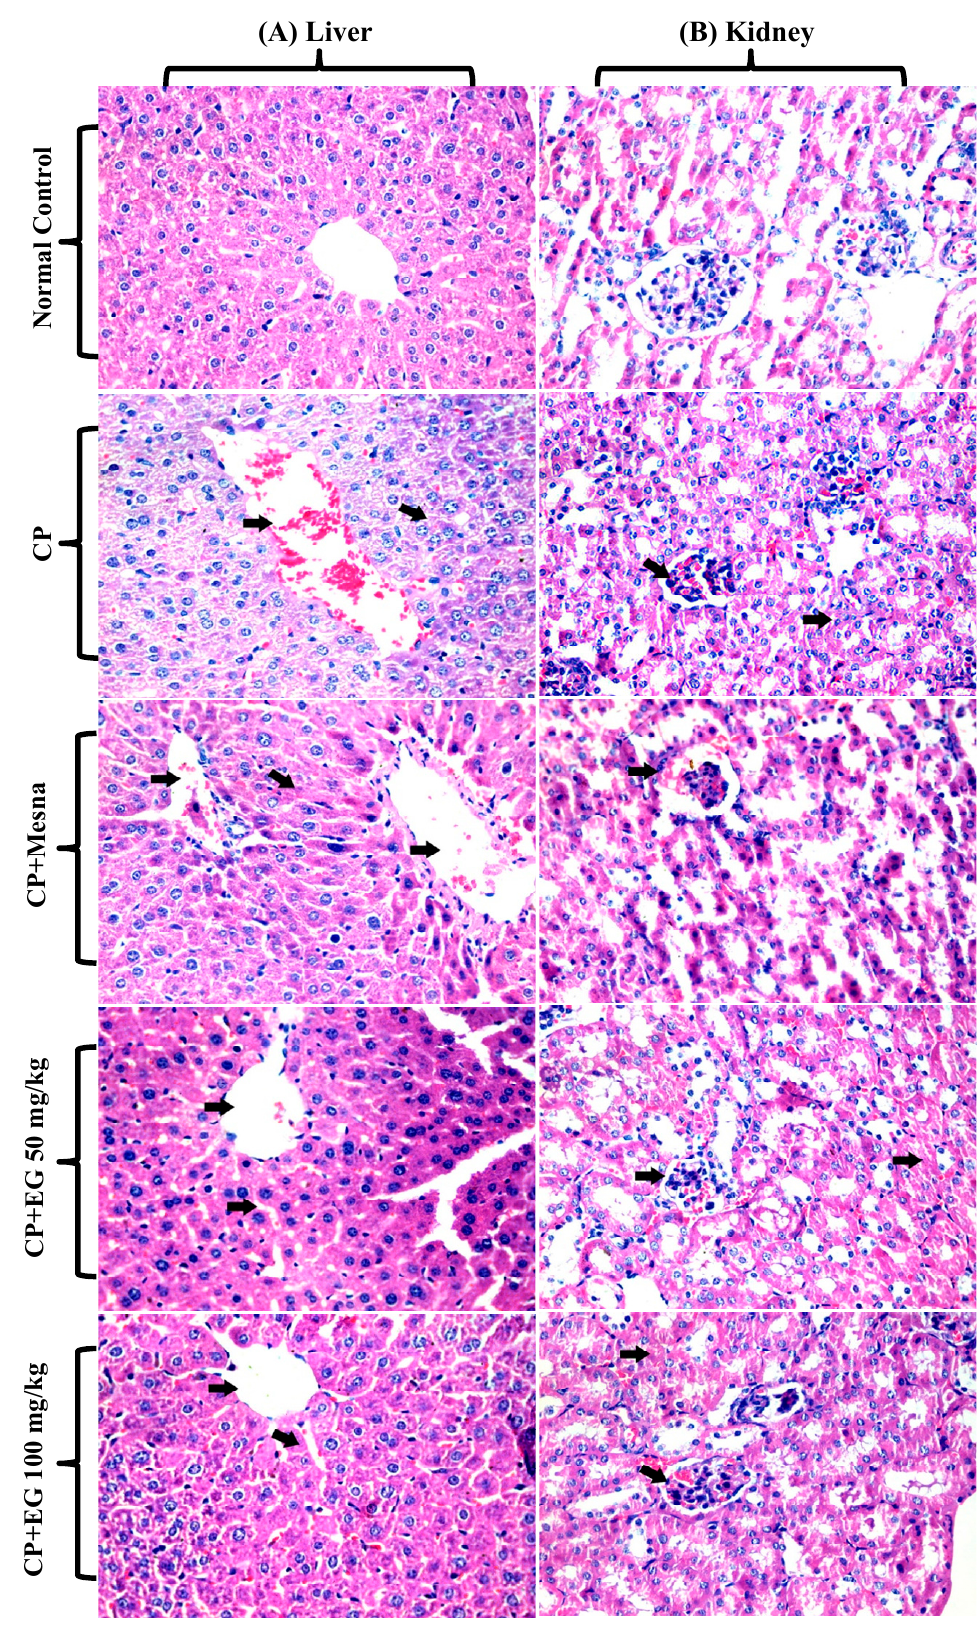
Figure 3. Photomicrographs showing the protective effects of EG pretreatment on CP–induced damage in hepatic ( A ) and renal ( B ) tissue sections stained with H&E (×400).